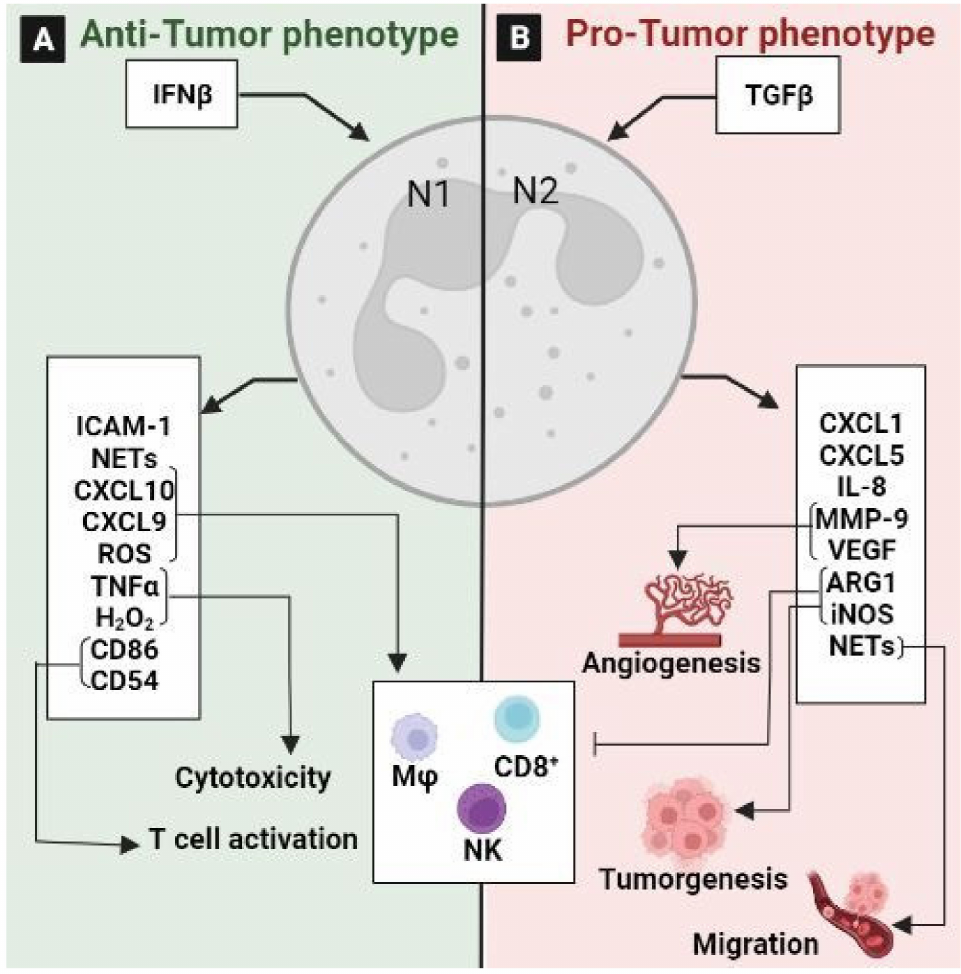
Figure 9. The role of tumor-associated neutrophils (TANs) in the tumor microenvironment. Neu- trophils polarize to anti-tumoral N1 and pro-tumoral N2 phenotypes: Depending on microenviron- mental stimuli, TAN can be polarized into two sub-populations. ( A ) Upon binding to the receptor, IFN β stimulated N1 and activated several transcription factors involved in the anti-tumoral effect of the N1 by increasing cytotoxicity through the production of TNF α and H 2 O 2 . Many downstream factors are activated by N1 neutrophils (such as ICAMs, NETs, CXCL9/10, ROS, CD86, and CD54) to induce T-cell activation and enhance the effective immune response. ( B ) Upon the activation of N2 by TGF β , various effectors are secreted to induce pathological angiogenesis (MMPs and VEGF) and cell migration (NETs), contributing thus to the inhibition of the anti-tumor immune response (ARG1 and iNOS). Abbreviations: TAN: Tumor-associated neutrophil, IL: interleukin, IFN: